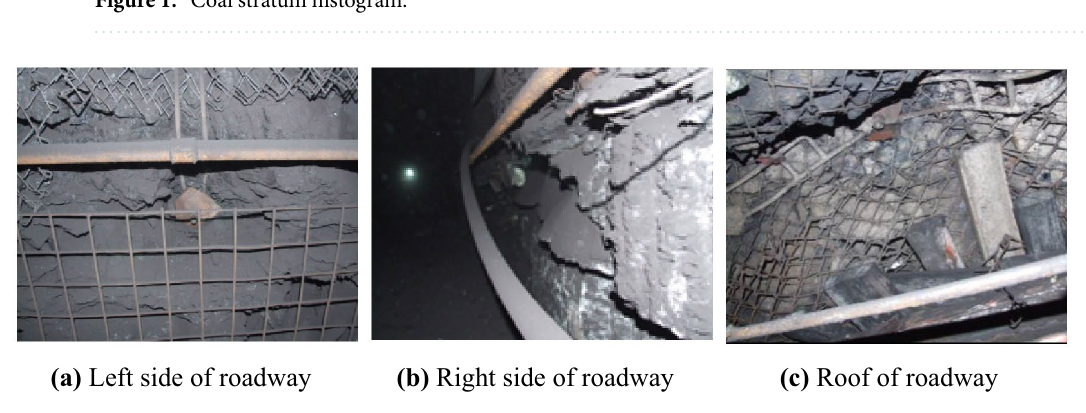
Figure 1. Coal stratum histogram.